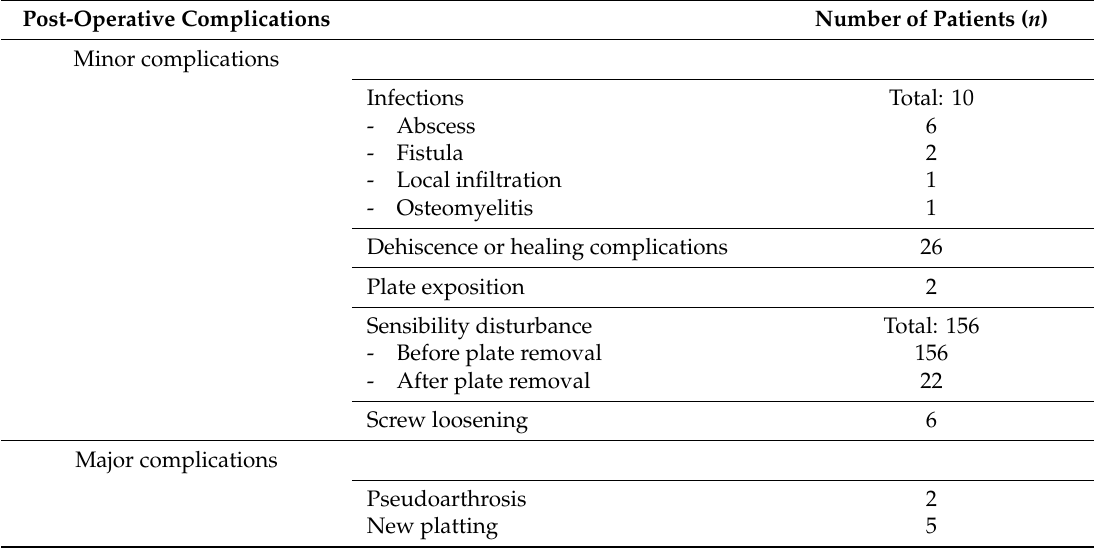
Table 3. Minor and major post-operative